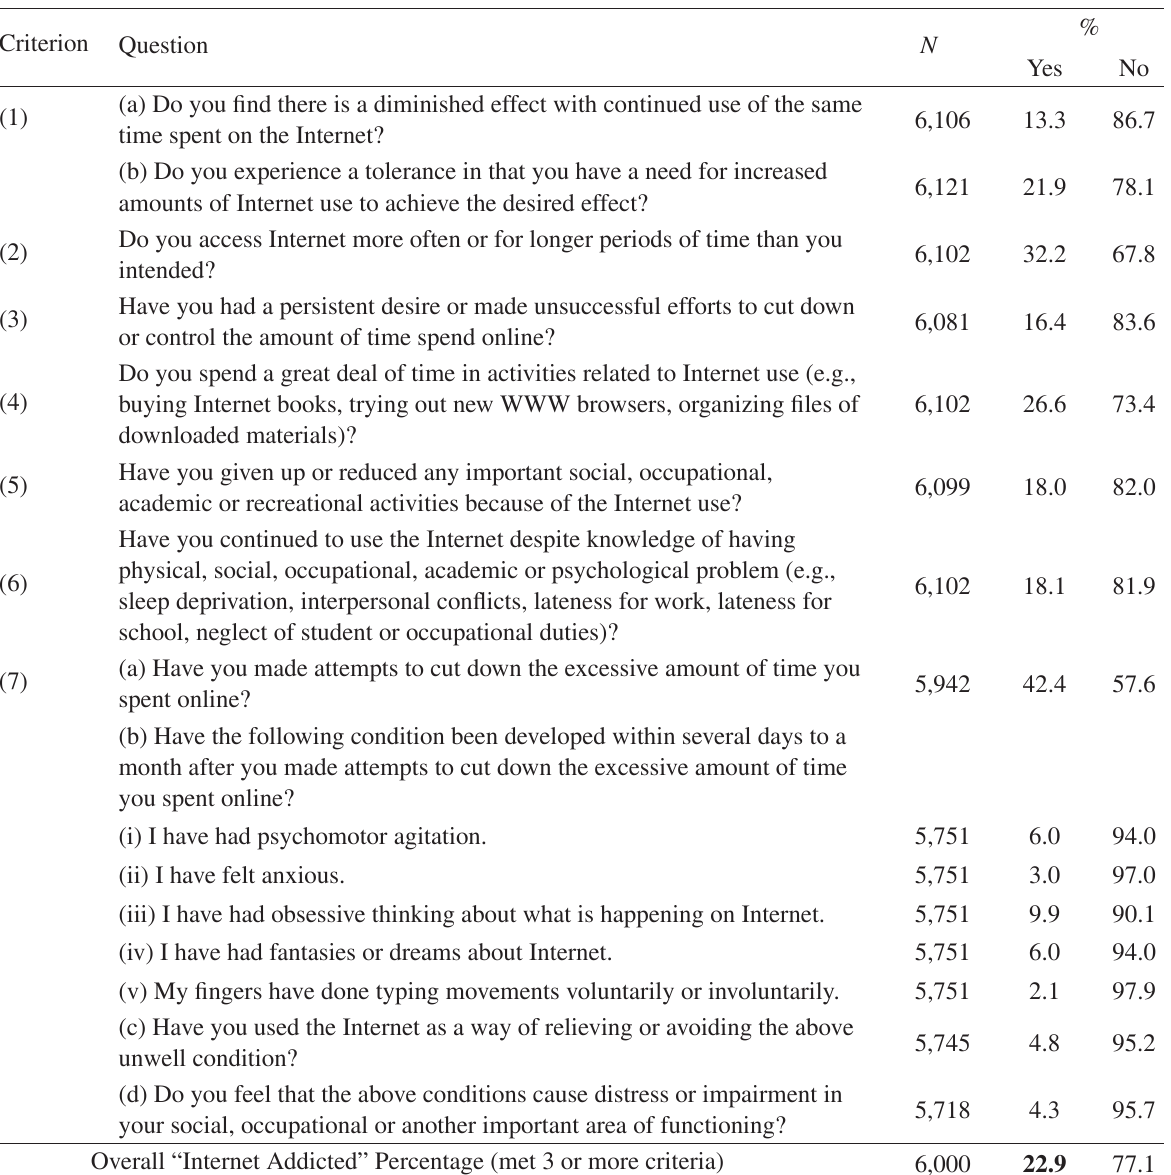
TABLE 6: Percentages of responses to the questions in CIA-Goldberg